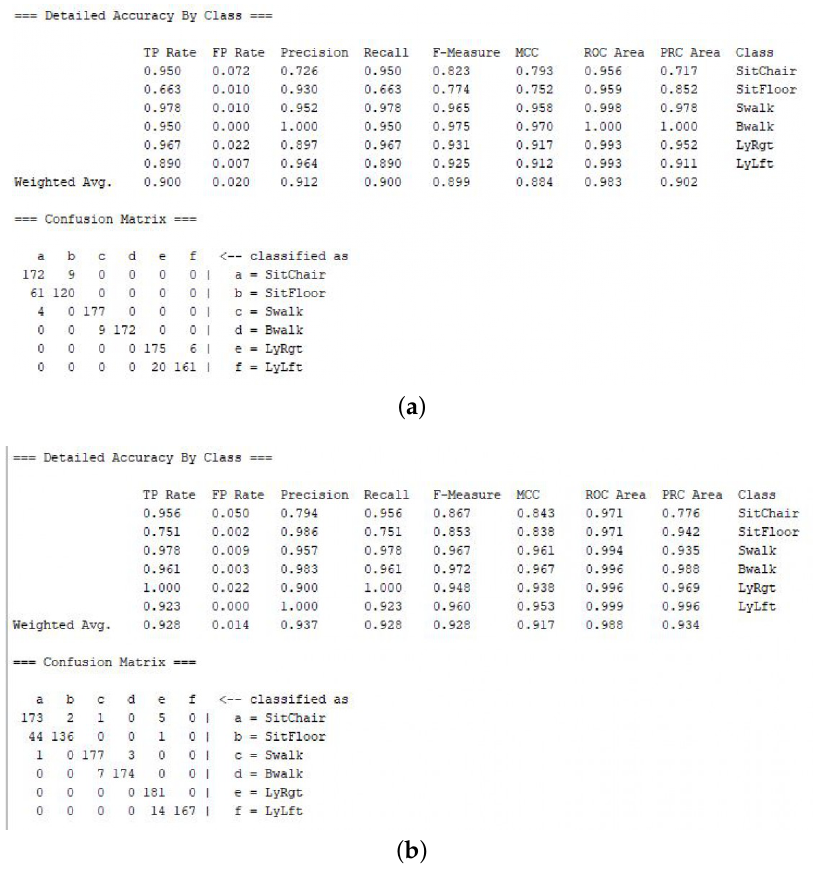
Figure 12. Confusion matrices for device independent activity recognition with D5 as the test device using an ensemble classifier, for ( a ) accelerometer sensor readings and ( b ) both accelerometer and gyroscope